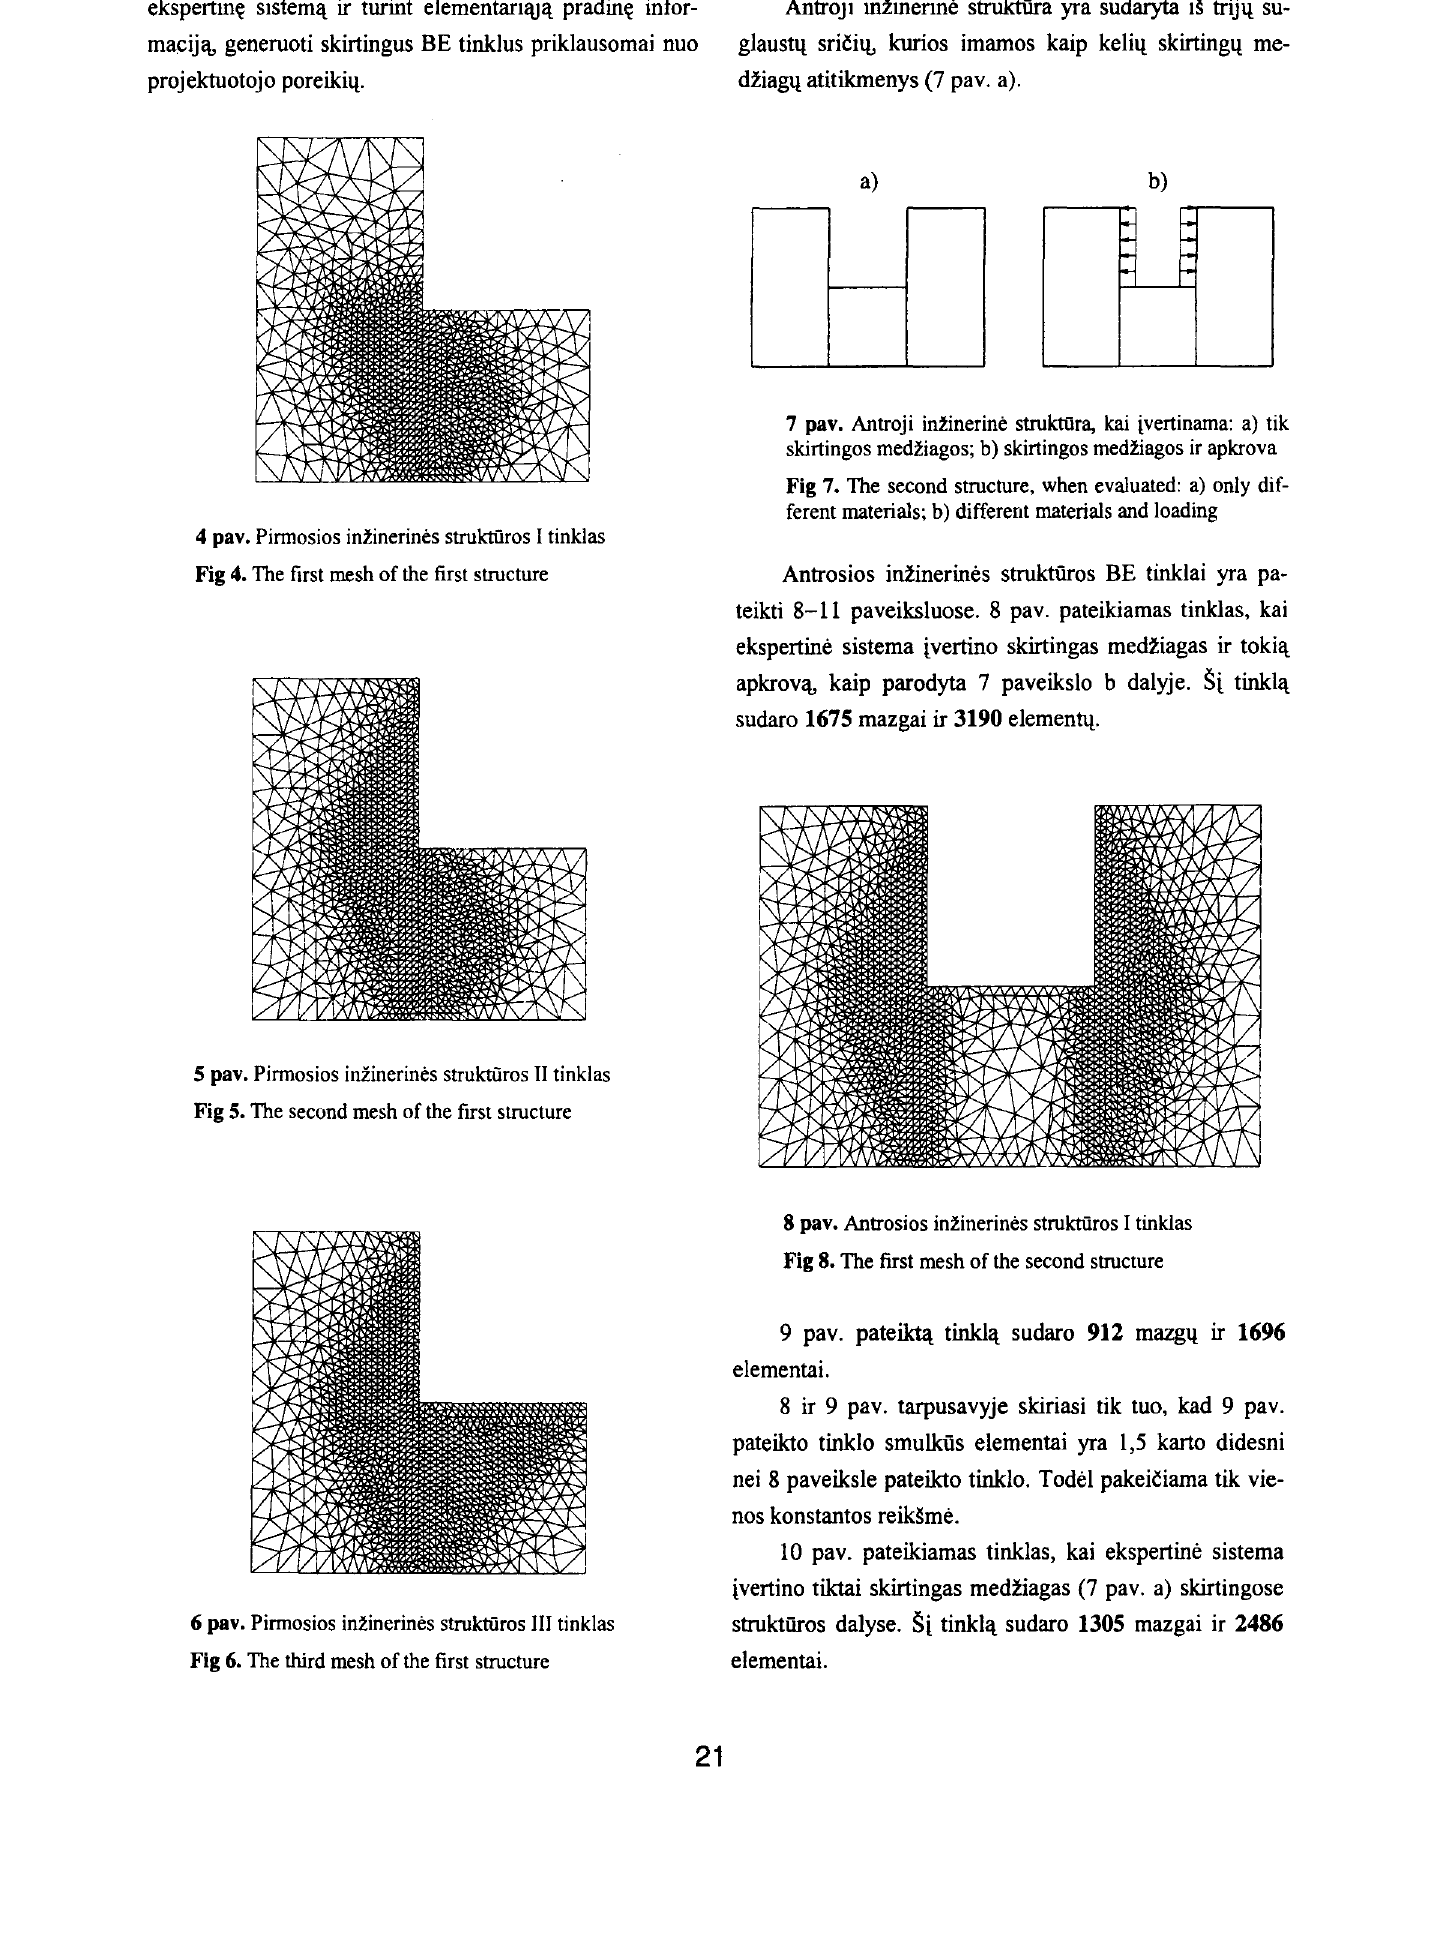
Fig 6. The third mesh of the first structure